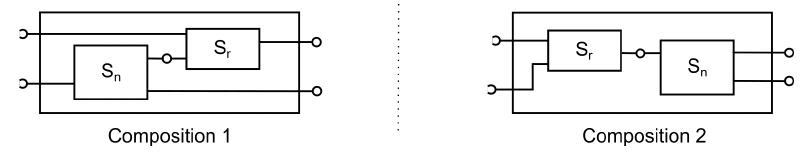
Figure 2. Example of service